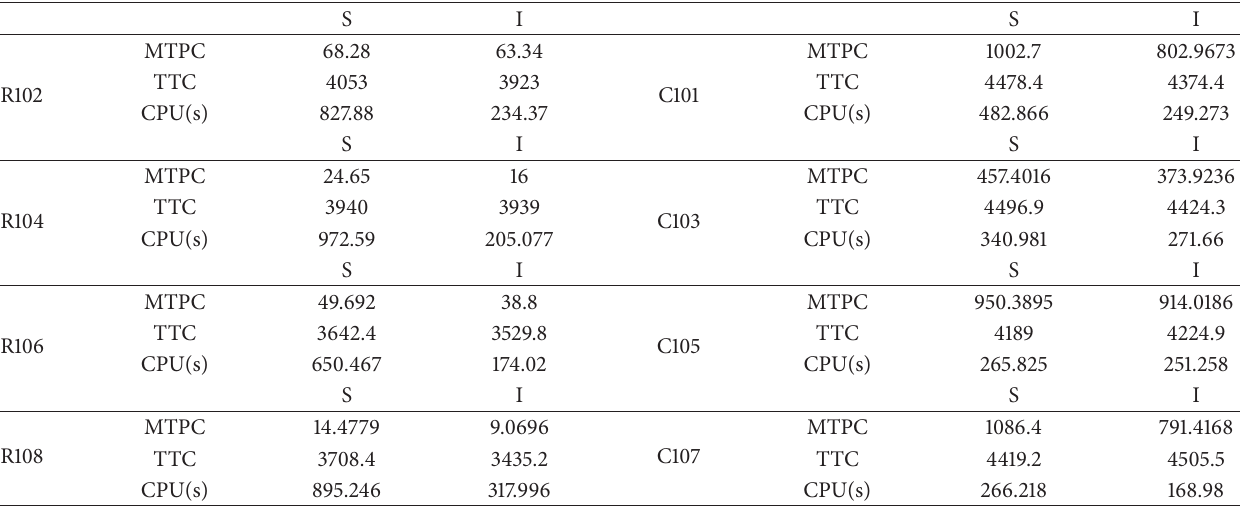
Table 4: Comparison of the calculated results in the Solomon standard test library.